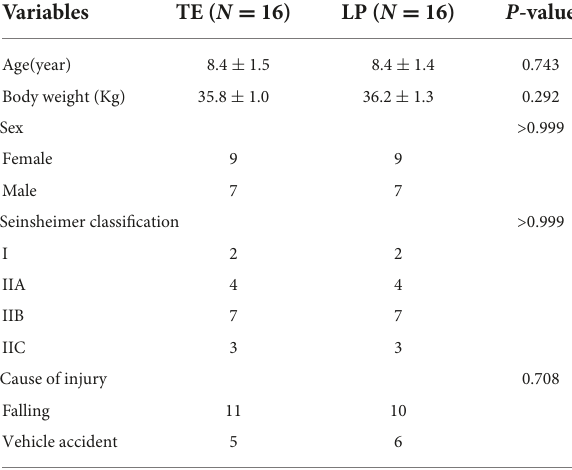
TABLE 1 Parameters of patients in the TE and LP group.